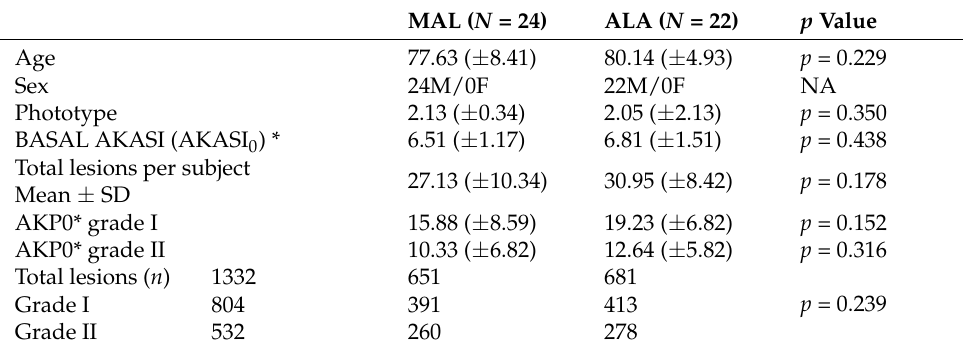
Table 1. Patients and actinic keratosis (AK) characteristics at the baseline.